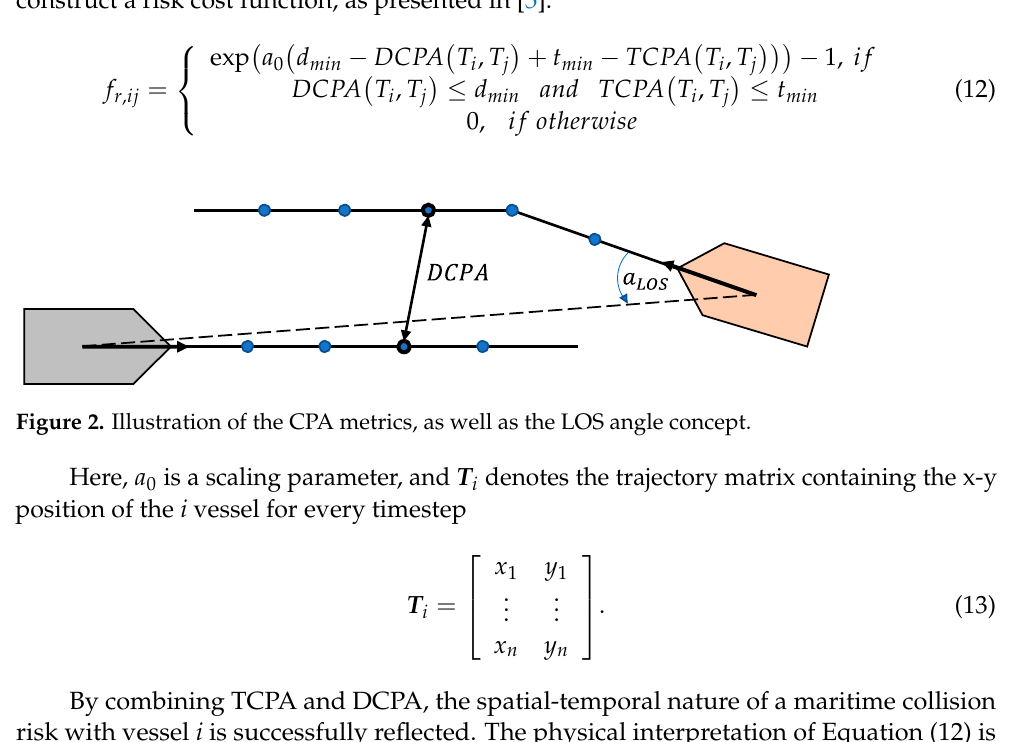
Table 1. Performance metrics of the produced RBF NN model.